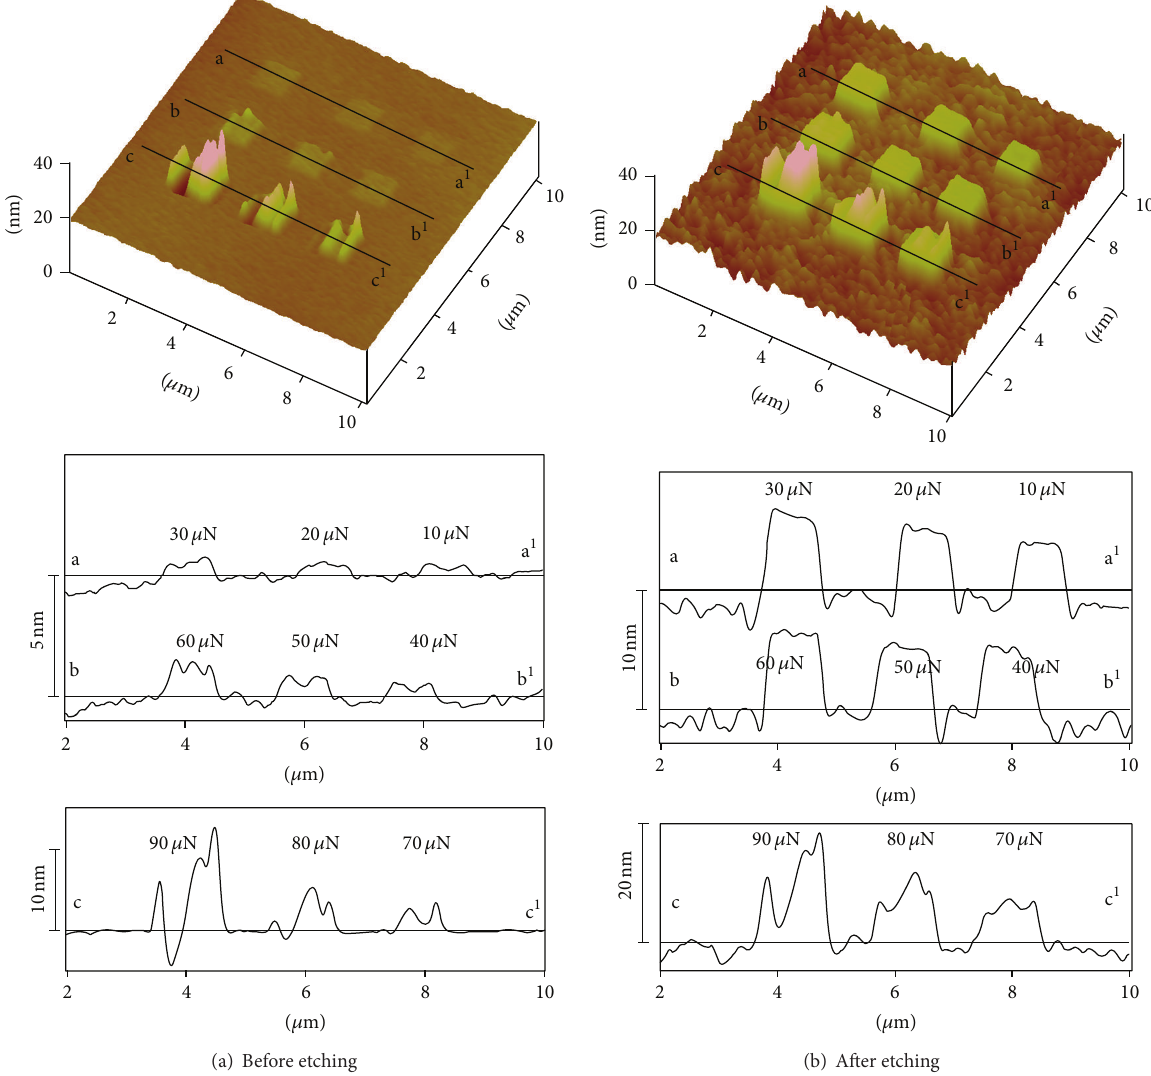
Figure 11: Load effects on protuberance and groove processing using a 140nm radius tip (a) before and (b) after KOH solution etching.